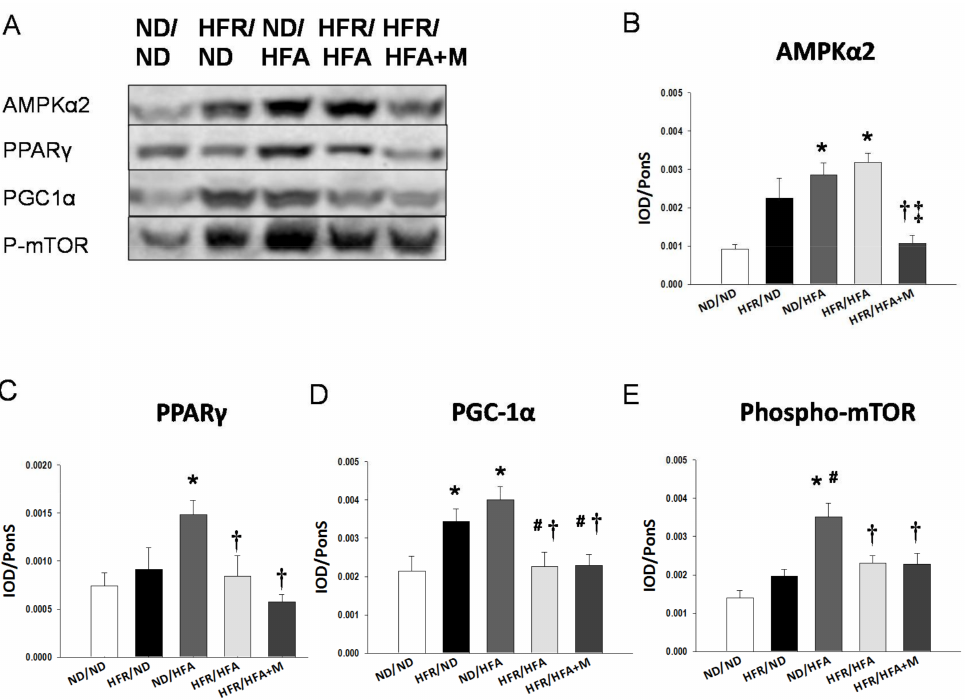
Figure 3. ( A ) Representative western blots and relative abundance of ( B ) AMPK α 2 (63 kDa); ( C ) PPAR γ (57 kDa); ( D ) PGC-1 α (90 kDa); and ( E ) phosphor-mTOR (289 kDa) in male offspring kidneys at 12 weeks of age. * p < 0.05 vs. ND/ND, # p < 0.05 vs. HFR/ND, † p < 0.05 vs. ND/HFA, ‡ p < 0.05 vs. HFR/HFA.